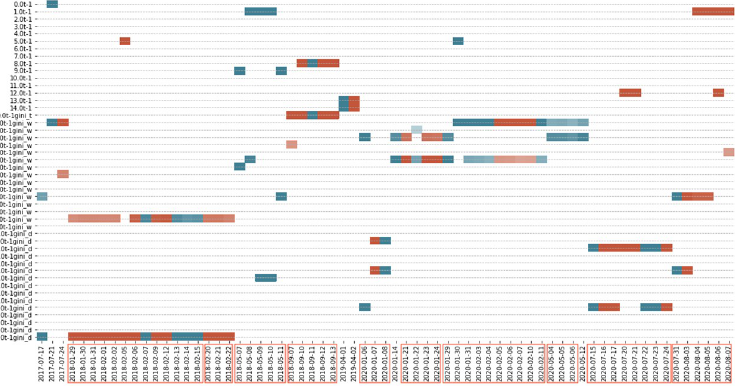
Fig 15. Different topic score chosen for prediction in the best model from the private data. The graph indicates the topic score measures were chosen for the predictions and the dates in the x-axis representing the last day of the regression period. The red (blue) colour represents where the topic score (benchmark) model outperformed the benchmark (topic score) model.